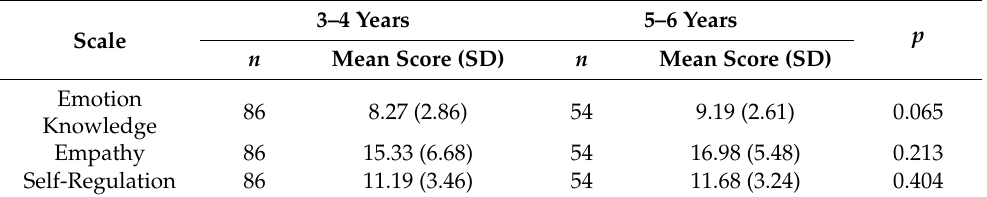
Table 1. Results of the distribution of the EMK screening scores in the age groups.